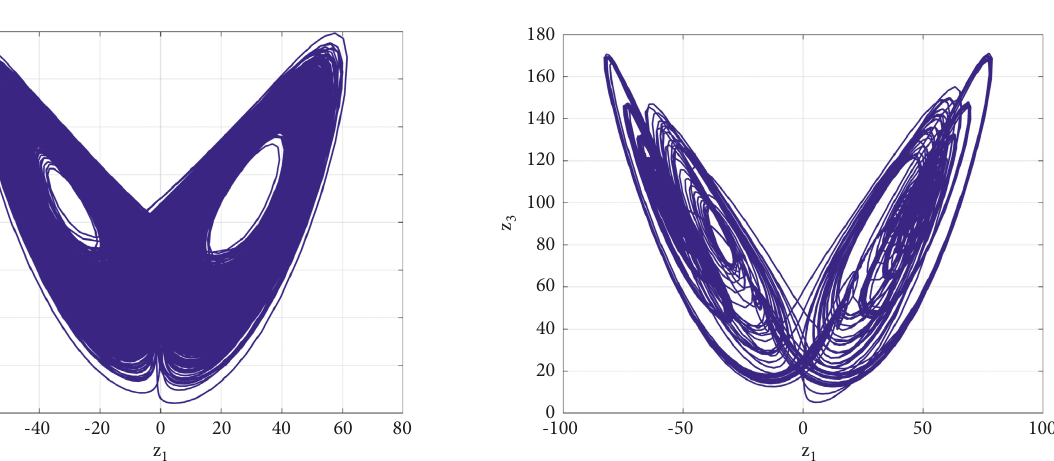
Figure 12: A chaotic attractor of the model (1) for b � 15 and ( a, c,d ) � ( 25 , 90 , 6 ) .